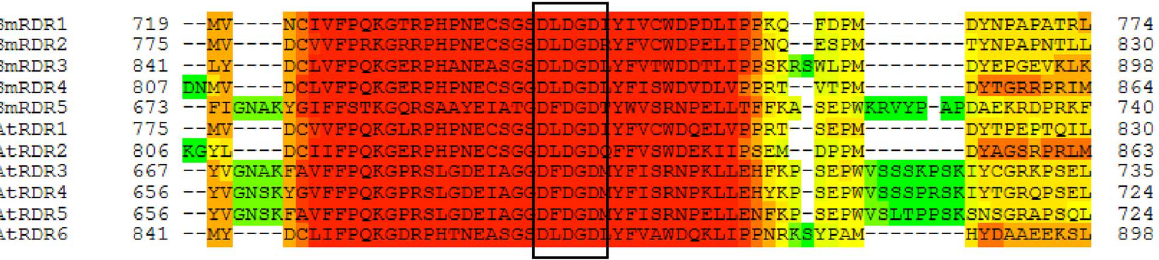
Figure 4. Alignment of partial sequences of RDR proteins in S.miltiorrhiza and Arabidopsis using T-coffee. The DLDGD/DFDGD signature is boxed. Different colors represent the quality of alignment with red for the highest quality, yellow for average, and green for the worst.